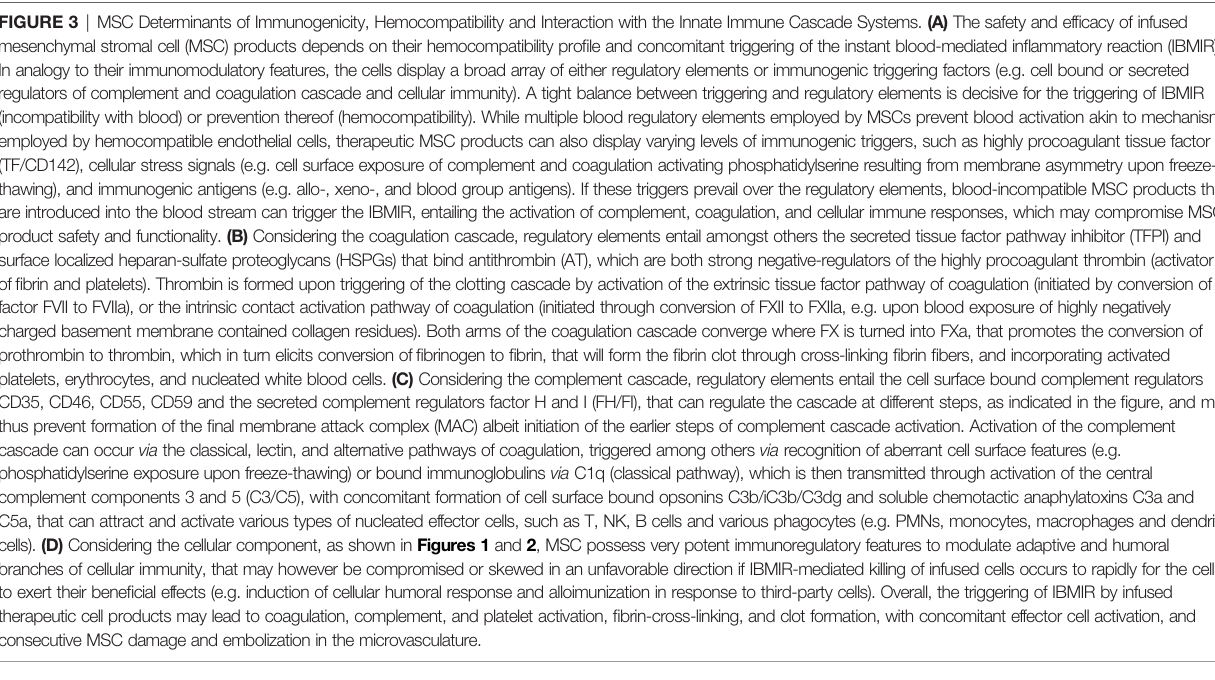
FIGURE 3 | MSC Determinants of Immunogenicity, Hemocompatibility and Interaction with the Innate Immune Cascade Systems. (A) The safety and ef fi cacy of infused mesenchymal stromal cell (MSC) products depends on their hemocompatibility pro fi le and concomitant triggering of the instant blood-mediated in fl ammatory reaction (IBMIR). In analogy to their immunomodulatory features, the cells display a broad array of either regulatory elements or immunogenic triggering factors (e.g. cell bound or secreted regulators of complement and coagulation cascade and cellular immunity). A tight balance between triggering and regulatory elements is decisive for the triggering of IBMIR (incompatibility with blood) or prevention thereof (hemocompatibility). While multiple blood regulatory elements employed by MSCs prevent blood activation akin to mechanism employed by hemocompatible endothelial cells, therapeutic MSC products can also display varying levels of immunogenic triggers, such as highly procoagulant tissue factor (TF/CD142), cellular stress signals (e.g. cell surface exposure of complement and coagulation activating phosphatidylserine resulting from membrane asymmetry upon freeze- thawing), and immunogenic antigens (e.g. allo-, xeno-, and blood group antigens). If these triggers prevail over the regulatory elements, blood-incompatible MSC products that are introduced into the blood stream can trigger the IBMIR, entailing the activation of complement, coagulation, and cellular immune responses, which may compromise MSC product safety and functionality. (B) Considering the coagulation cascade, regulatory elements entail amongst others the secreted tissue factor pathway inhibitor (TFPI) and surface localized heparan-sulfate proteoglycans (HSPGs) that bind antithrombin (AT), which are both strong negative-regulators of the highly procoagulant thrombin (activator of fi brin and platelets). Thrombin is formed upon triggering of the clotting cascade by activation of the extrinsic tissue factor pathway of coagulation (initiated by conversion of factor FVII to FVIIa), or the intrinsic contact activation pathway of coagulation (initiated through conversion of FXII to FXIIa, e.g. upon blood exposure of highly negatively charged basement membrane contained collagen residues). Both arms of the coagulation cascade converge where FX is turned into FXa, that promotes the conversion of prothrombin to thrombin, which in turn elicits conversion of fi brinogen to fi brin, that will form the fi brin clot through cross-linking fi brin fi bers, and incorporating activated platelets, erythrocytes, and nucleated white blood cells. (C) Considering the complement cascade, regulatory elements entail the cell surface bound complement regulators CD35, CD46, CD55, CD59 and the secreted complement regulators factor H and I (FH/FI), that can regulate the cascade at different steps, as indicated in the fi gure, and may thus prevent formation of the fi nal membrane attack complex (MAC) albeit initiation of the earlier steps of complement cascade activation. Activation of the complement cascade can occur via the classical, lectin, and alternative pathways of coagulation, triggered among others via recognition of aberrant cell surface features (e.g. phosphatidylserine exposure upon freeze-thawing) or bound immunoglobulins via C1q (classical pathway), which is then transmitted through activation of the central complement components 3 and 5 (C3/C5), with concomitant formation of cell surface bound opsonins C3b/iC3b/C3dg and soluble chemotactic anaphylatoxins C3a and C5a, that can attract and activate various types of nucleated effector cells, such as T, NK, B cells and various phagocytes (e.g. PMNs, monocytes, macrophages and dendritic cells). (D) Considering the cellular component, as shown in Figures 1 and 2 , MSC possess very potent immunoregulatory features to modulate adaptive and humoral branches of cellular immunity, that may however be compromised or skewed in an unfavorable direction if IBMIR-mediated killing of infused cells occurs to rapidly for the cells to exert their bene fi cial effects (e.g. induction of cellular humoral response and alloimunization in response to third-party cells). Overall, the triggering of IBMIR by infused therapeutic cell products may lead to coagulation, complement, and platelet activation, fi brin-cross-linking, and clot formation, with concomitant effector cell activation, and consecutive MSC damage and embolization in the